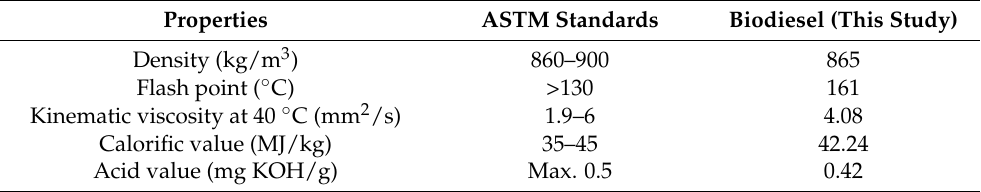
Table 6. Comparison of physicochemical properties of produced biodiesel with ASTM D6571 standards.